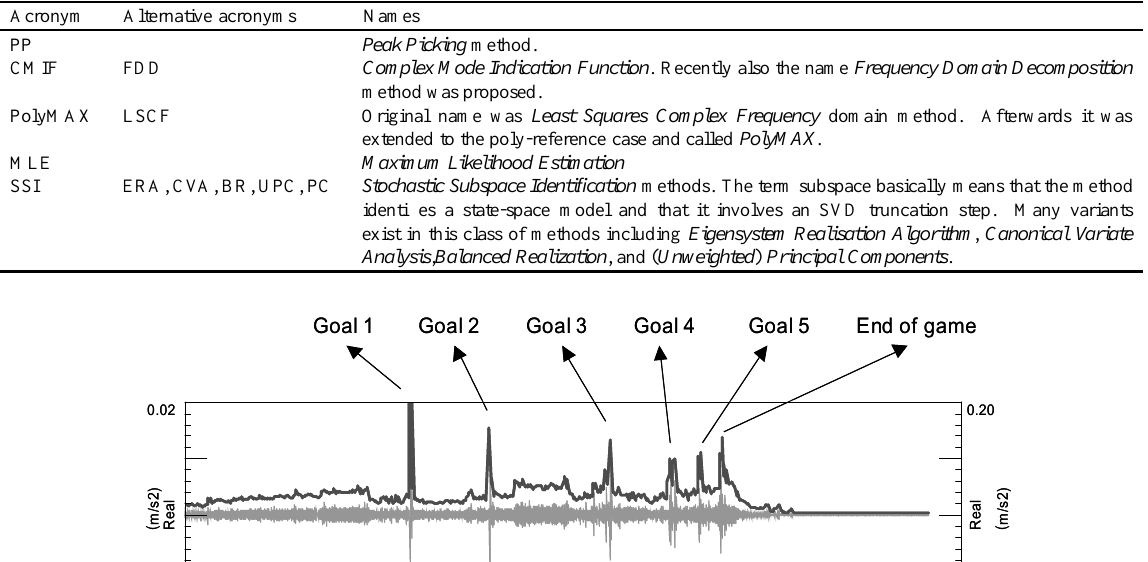
Table 2 Overview of parameter estimation methods that are found in OMA literature. An acronym and a name designate the methods. Alternative names, which can be found in literature for basically the same methods, are also represented in the table